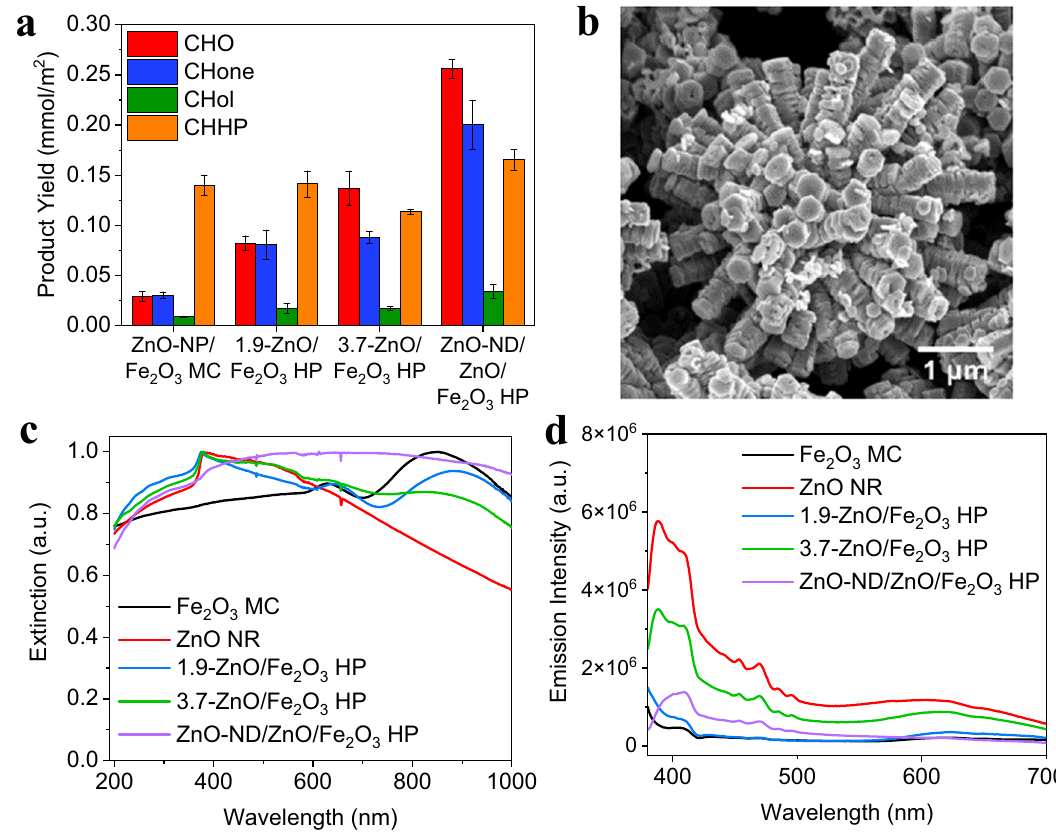
Fig. 4 | Understanding the in fl uence of HP morphology on reaction. a Product yield from the oxidation of CH in a 1:1 (by vol) CH/aqueous H 2 O 2 emulsion with 1mg/mLcatalyst and 1MH 2 O 2 underbroadspectrumlightfor16hoursforvarious ZnO-containing catalysts, normalized by particle surface area. b SEM of ZnO-ND/ ZnO/Fe 2 O 3 HP consisting of two-dimensional ZnO nanodiscs assembled around